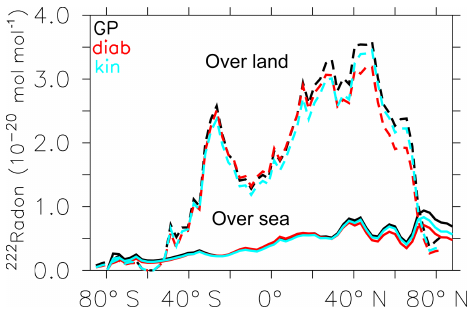
Figure 3. Zonal mean 222 Rn mixing ratio between 800 and 1013hPa (weighted by the level thickness) over land (dashed) and over sea (solid) for GP (black line), LG(diab) (red line), and LG(kin) (light blue line).